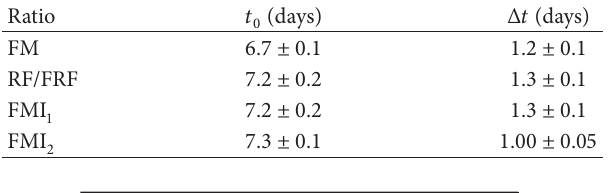
Table 1: Fitting parameters for all fluorescence ratios.